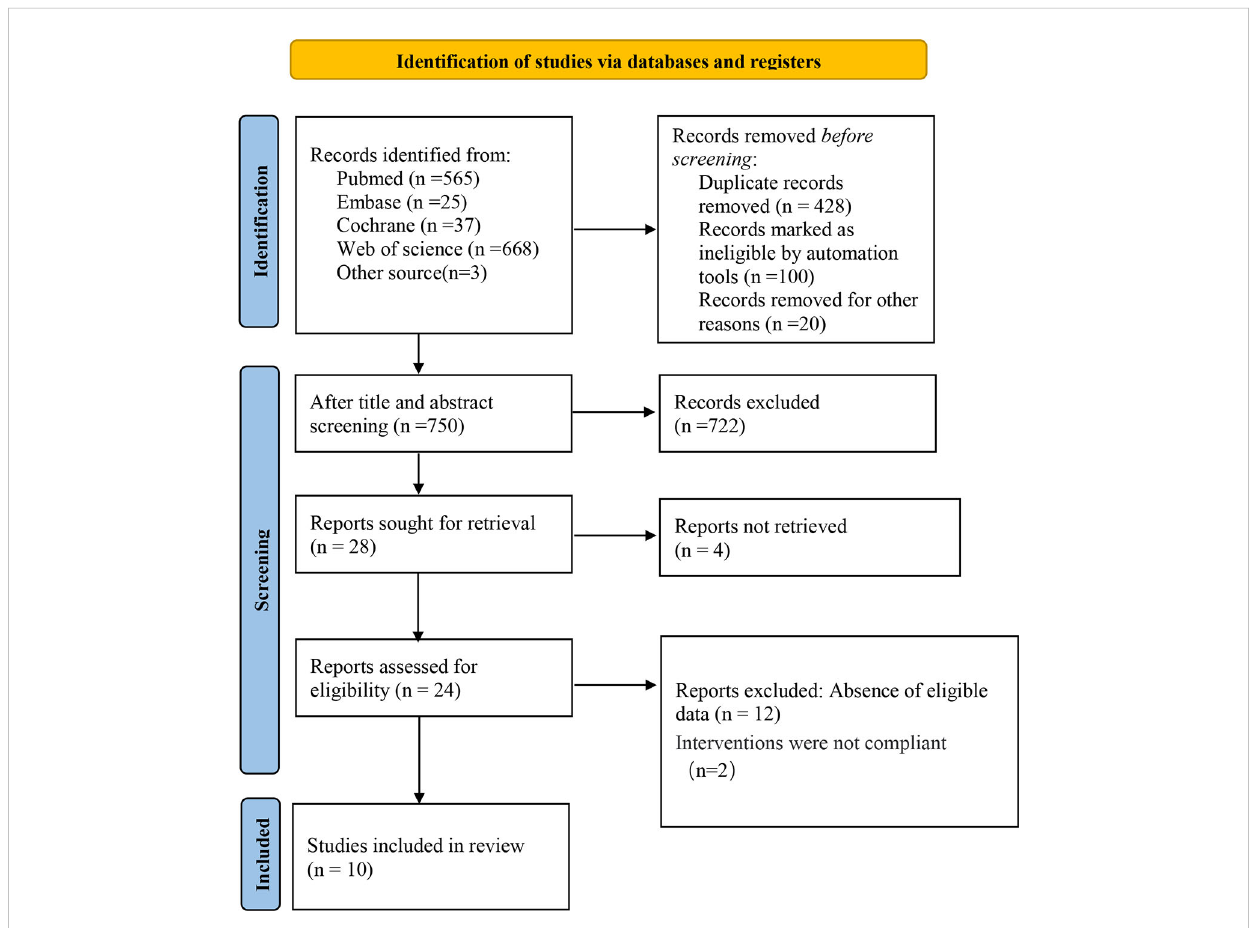
FIGURE 1 Literature screening fl